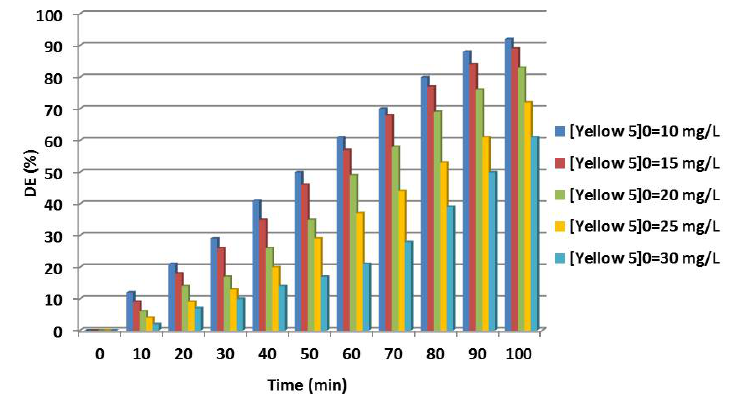
Fig. 11. Yellow 5 concentration influence on degradation efficiency